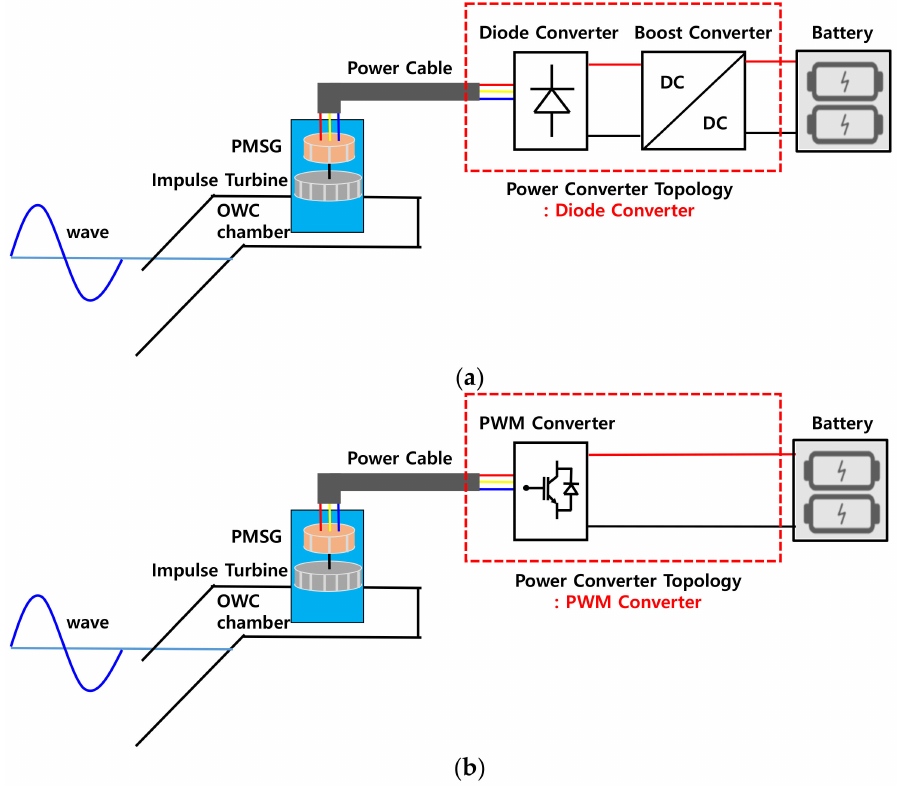
Figure 3. Power converter topologies for wave energy converter: ( a ) Diode converter; ( b ) PWM